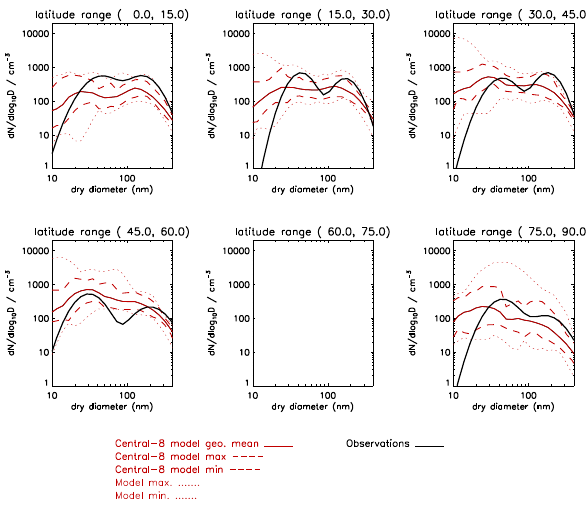
Figure 20. Northern Hemisphere annual-mean central-model sim- ulated size distributions in the marine boundary layer averaged into 15 ◦ latitude ranges to compare against the compilation of 30yr of cruise DMPS/APS measurements from Heintzenberg et al. (2000). The solid line shows the geometric mean of the central-8 models, dashed lines indicate the maximum and minimum of the central-8, while dotted lines indicate the maximum and minimum over all 12